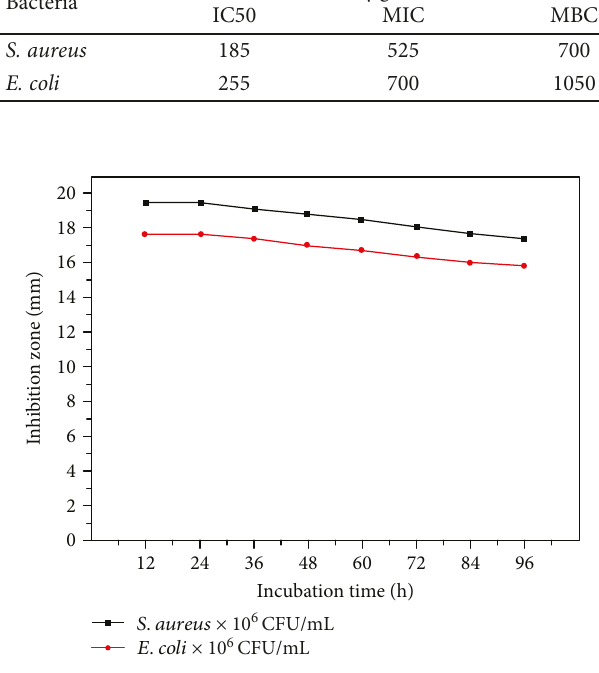
Figure 9: Long-lasting antibacterial property of CGCe. Table 2: Color test results of the ink.